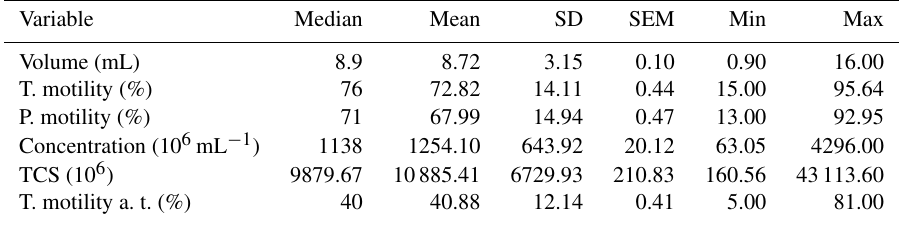
Table 1. Descriptive statistics of the dataset. Variable